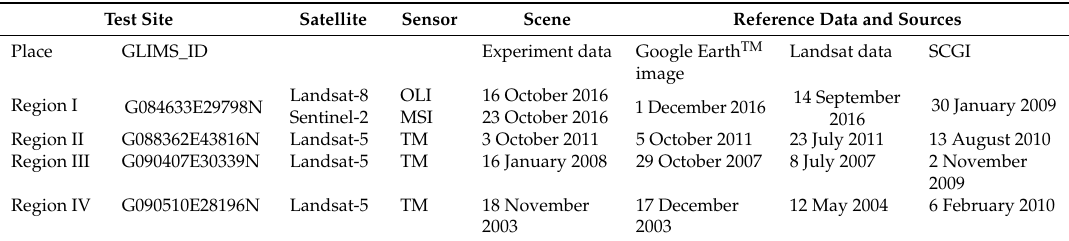
Table 1. Description of experimental scenes and corresponding reference data.